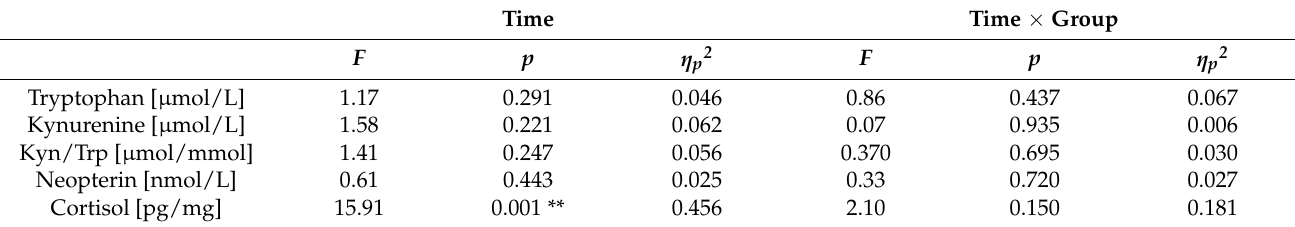
Table 4. RM-ANOVA results for biomarkers concentrations (tryptophan, kynurenine, kynurenine to tryptophan ratio [Kyn/Trp], neopterin, cortisol).